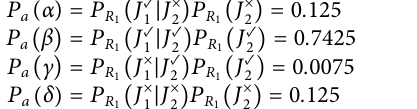
Frontiers in Robotics and AI |